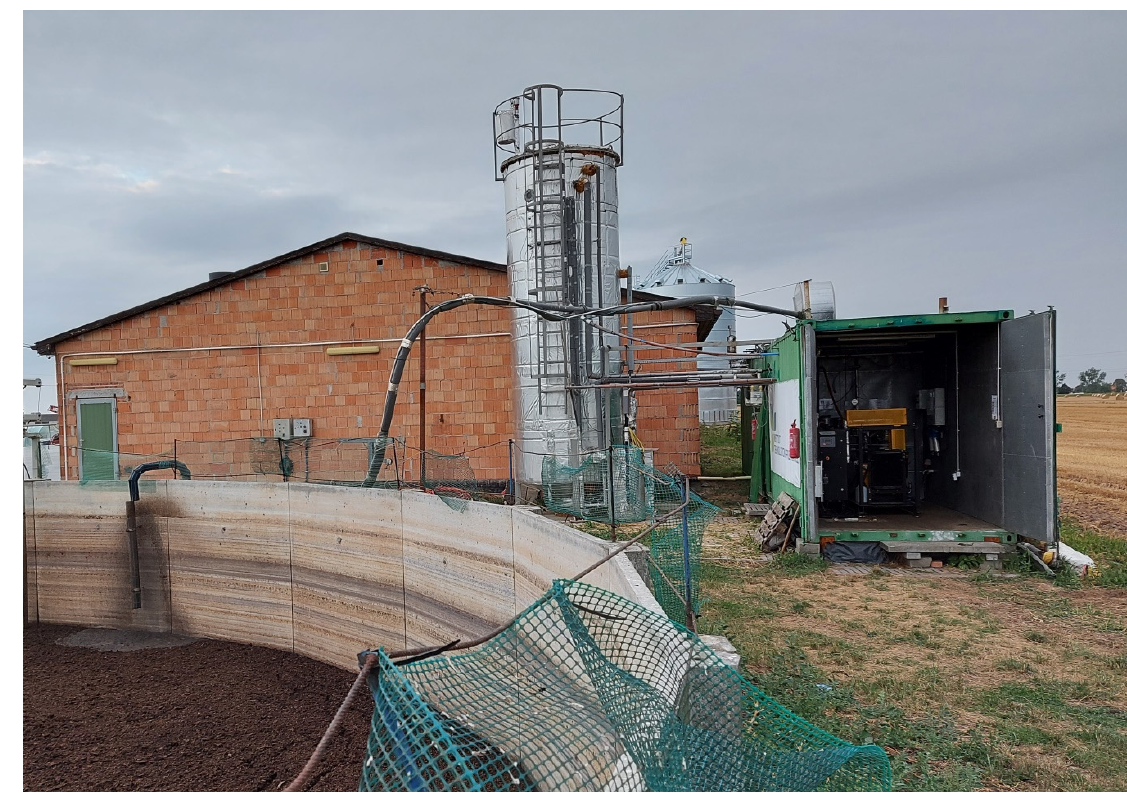
Figure 2. Pilot biogas production—view, from the right: a container with, among others, desulfurizers; fermenter; livestock building (pigsty); lagoon (reservoir for reacted ferment) [photo by Grzegorz Wa ł owski].